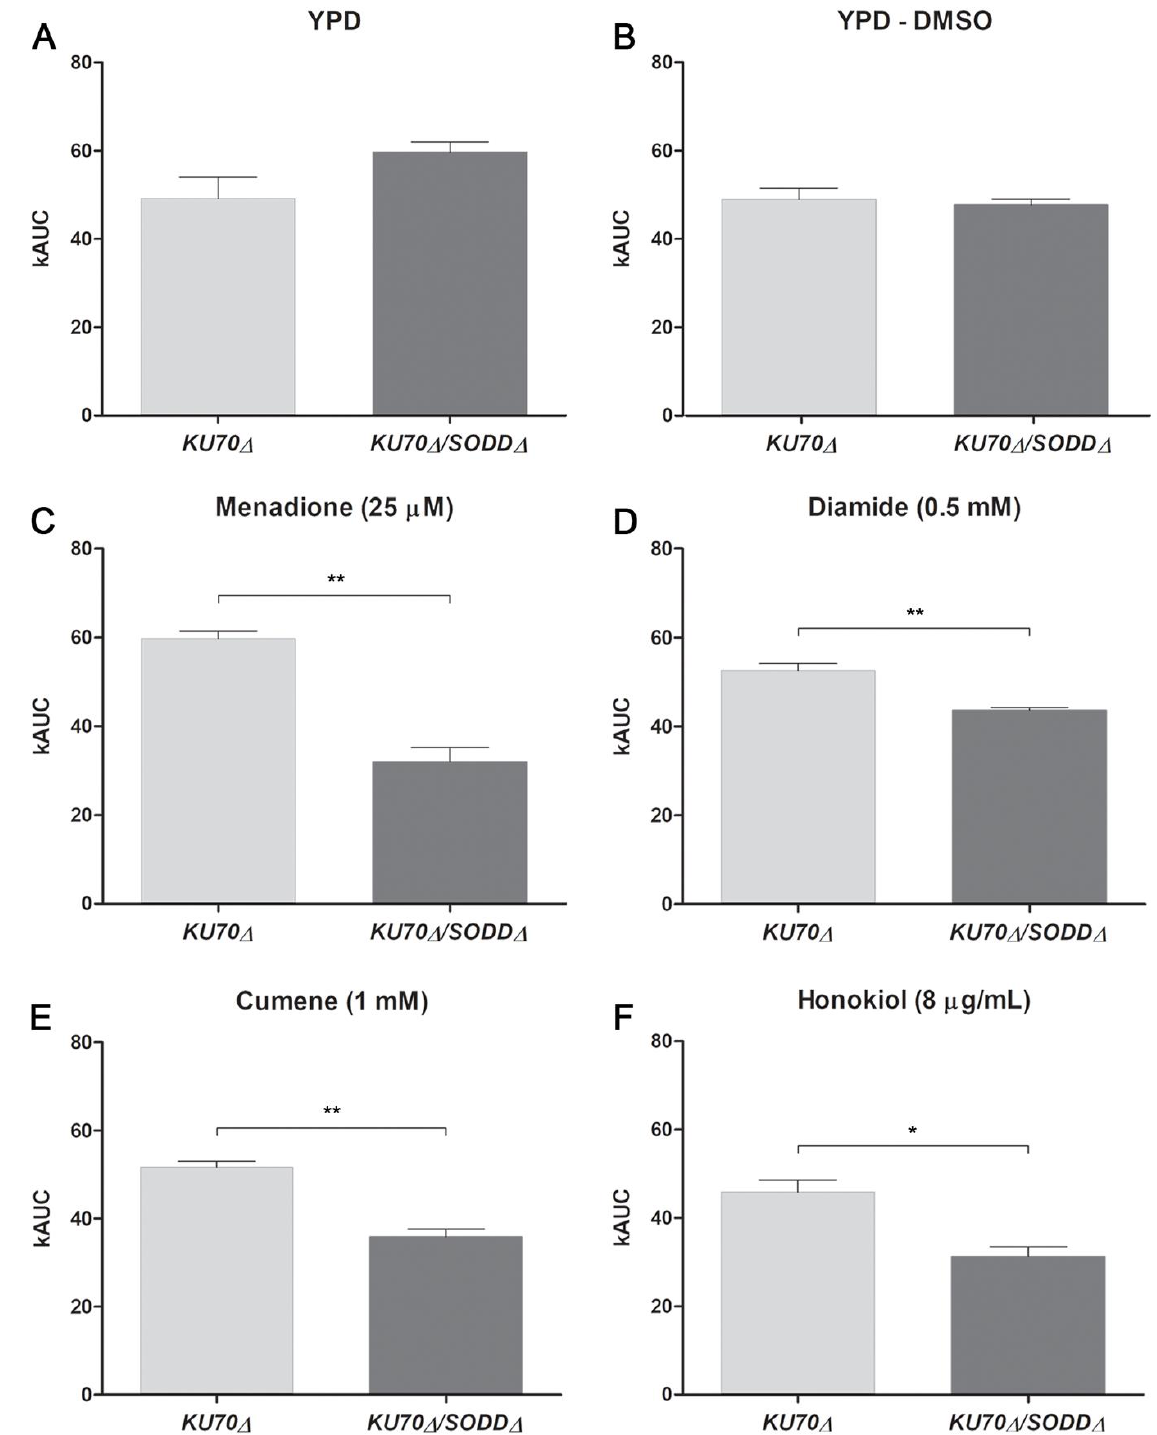
Figure 2. Laser nephelometry evaluation of the fungal growth. Growth of the SODD defective mutant ( KU70 ∆ /SODD ∆ ) and its parent strain ( KU70 ∆ ) was monitored for 6 days by laser nephelometry in yeast extract-peptone-dextrose (YPD) broth in the presence of oxidizing agents. Positive controls were run in parallel: YPD alone ( A ) served as the control for all the tested agents except menadione, for which YPD plus dimethyl sulfoxide (DMSO) ( B ) served as the solvent control. ( C ) : Menadione 25 μM. ( D ): Diamide 0.5 mM. ( E ): Cumene 1 mM. ( F ) : Honokiol 8 μg/mL. The area under curve ( AUC) values were calculated from curves expressing the relative nephelometric unit (RNU) as a function of time in h. Results correspond to the mean of triplicate determinations. Error bars correspond to the standard error of the mean. *, p < 0.05. **, p < 0.01.